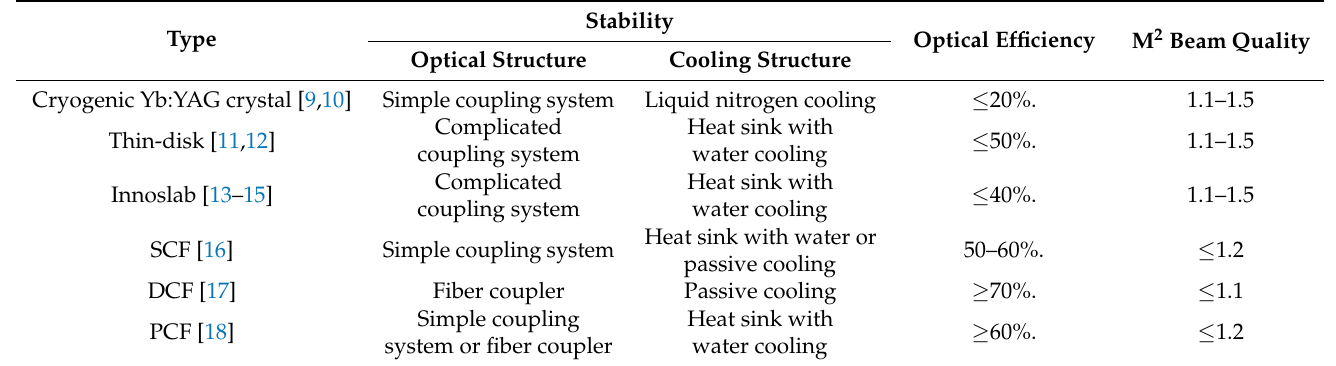
Table 1. Comparison of different picosecond amplification